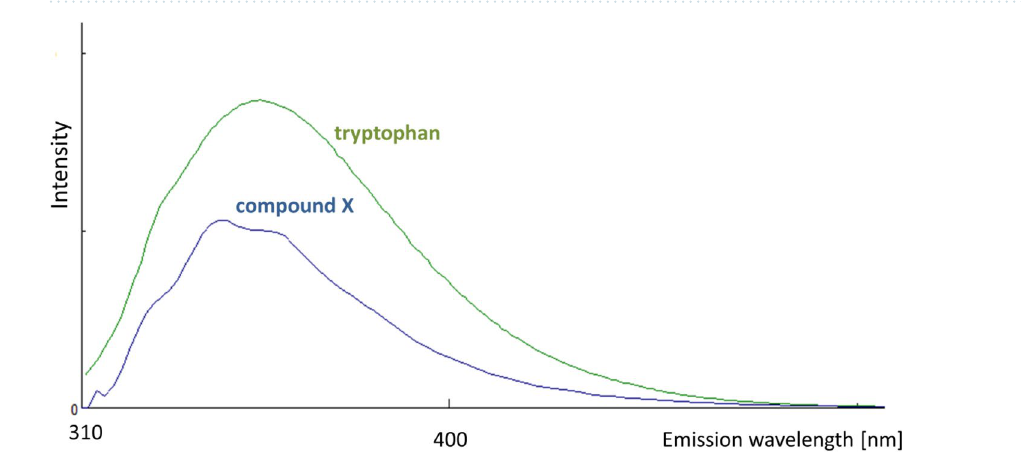
Figure 4. Left: UV absorbance of aqueous humor of goose, chicken and turkey. Right: 800 MHz NMR of the same samples. Conditions are described in “Methods” section (liquid chromatography and spectroscopy and NMR Spectroscopy).